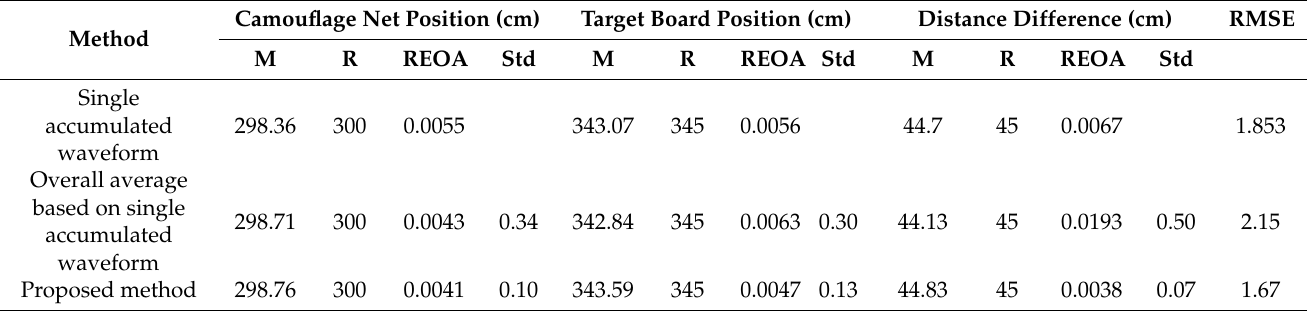
Table 6. The comparison of the waveform accumulation method and the proposed method.